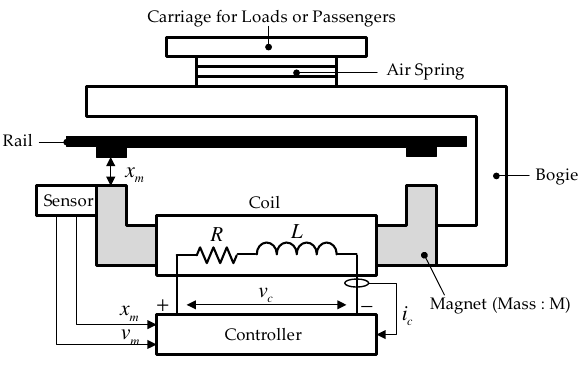
Figure 1. MAGLEV system